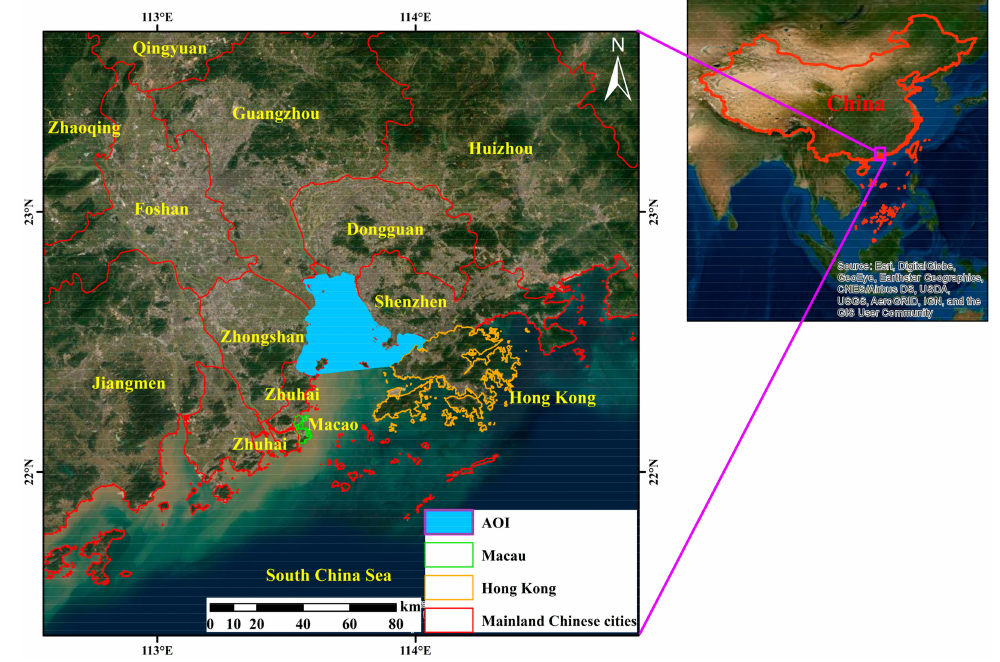
Figure 2. Area of interest (AOI) in southern China as the LSTn method test